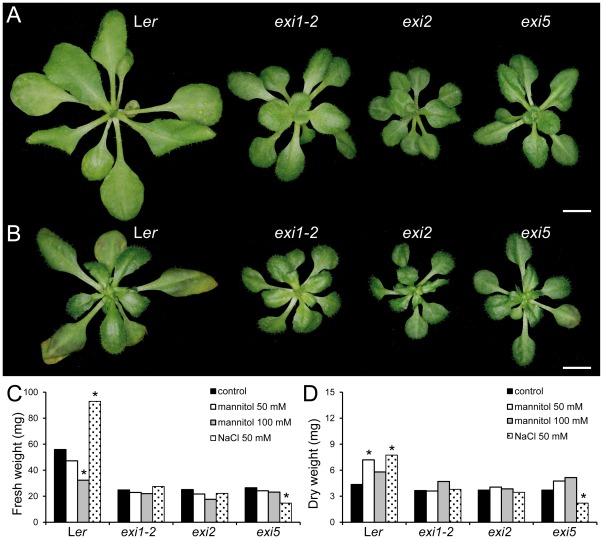
Osmotic stress tolerance of the exi mutants.(A–B) Rosette morphology in seedlings grown on media (A) without mannitol or (B) supplemented with 100 mM mannitol (B). (C, D) Effects of different concentrations of mannitol or NaCl on the (C) fresh weight (D) dry weight of 26-day-old rosettes. Plants were grown for 19 days on half-strength MS agar medium and then transferred to half-strength MS agar plates supplemented or not with either mannitol or NaCl at different concentrations. Photographs were taken after one week of treatment, and rosettes were immediately weighed (fresh weight) or dried for 16 h at 60°C and then weighted (dry weight). Asterisks indicate significant differences from the control plates without mannitol or NaCl (P value<0.01). Each column represents the mean of three measurements (8–10 rosettes each). Scale bars indicate 2 mm.